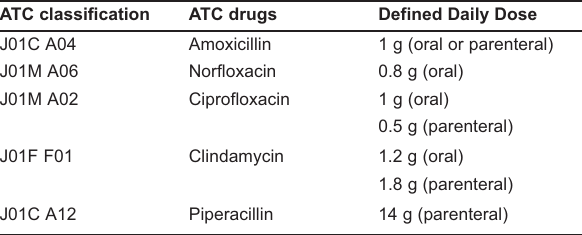
TABLE 2 Examples of Defined Daily Doses ATC